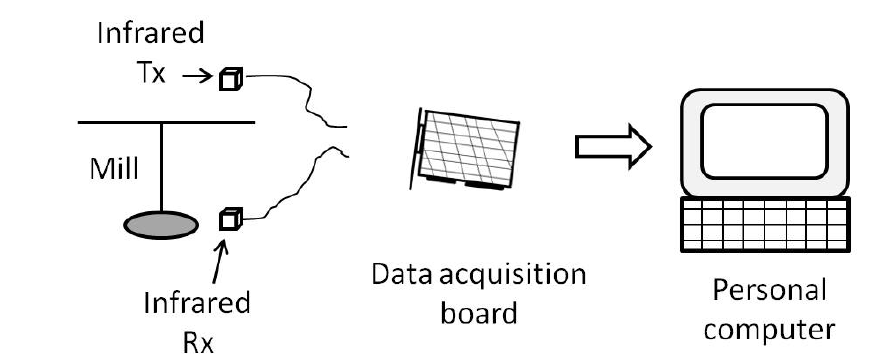
Figure 10. Block diagram of mill